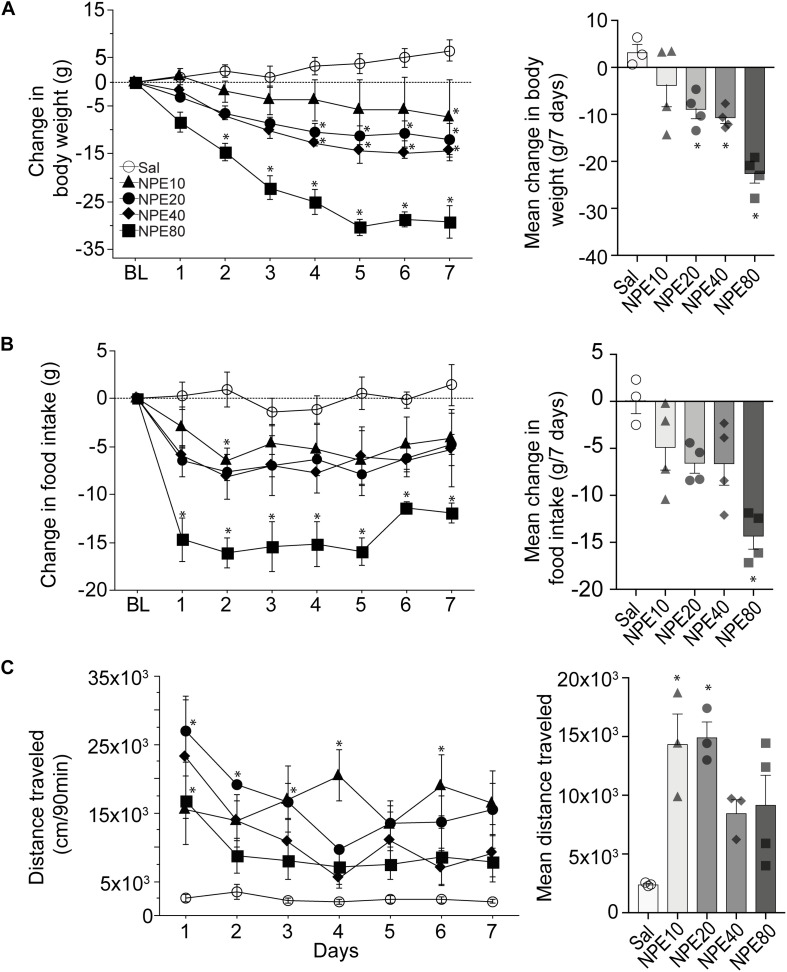
D-Norpseudoephedrine (NPE) leads to weight loss, suppresses food intake, and NPE increases locomotor activity. (A)
Left panel: Change in body weight (g) relative to baseline day (BL) over 7 consecutive injections of saline (Sal) or NPE at 10-, 20-, 40-, and 80-mg/kg doses (NPE10, NPE20, NPE40, and NPE80, respectively). The horizontal dotted line represents no change in body weight relative to BL. Right panel: Average body weight loss over 7 consecutive days of treatment. (B)
Left panel: Change in chow intake (g) over 7 days. Right panel: Average change in chow intake. (C)
Left panel: Locomotor activity induced by different doses of NPE. Right panel: Mean distance traveled follows inverted-U shape response. Bars represent the mean ± SEM. *p < 0.05 significantly different from saline-treated rats.